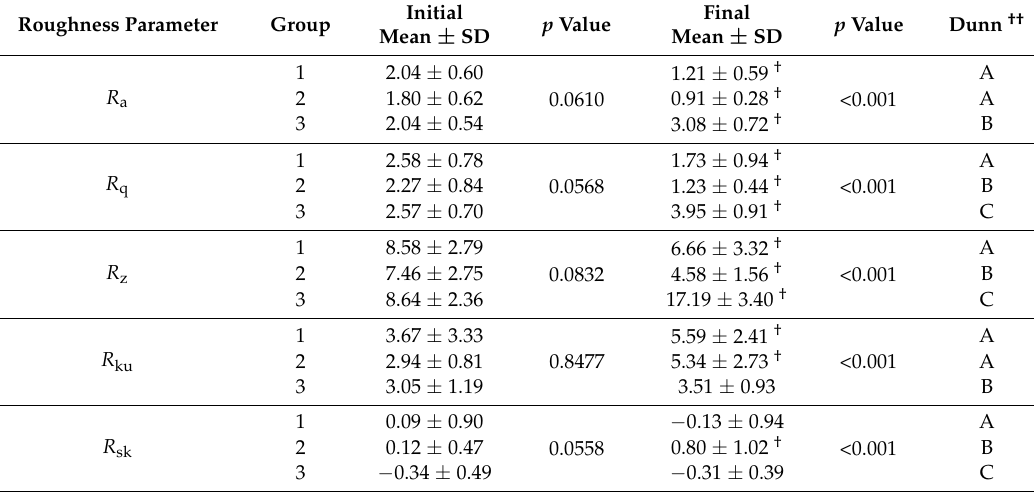
Table 2. Results of the Initial and Final Roughness Means and Standard Deviation (SD) within Groups ( Y -axis), in µ m.